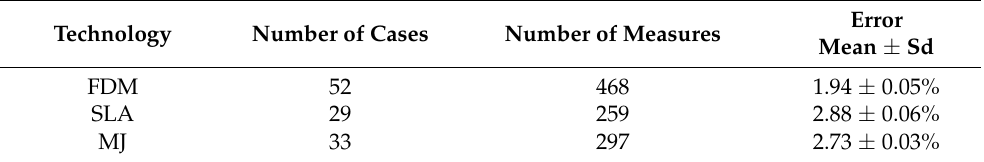
Table 2. Manufacturing errors.